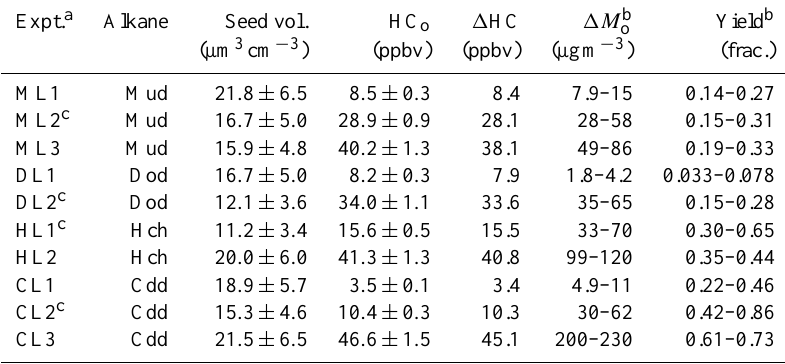
Table 3. Low-NO x experimental details.